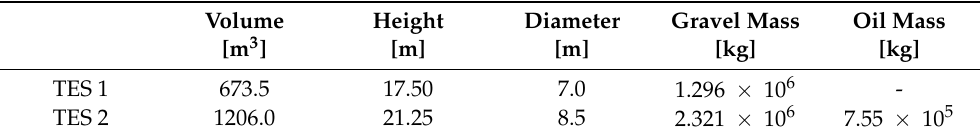
Table 1. Main characteristics of the two TES systems.